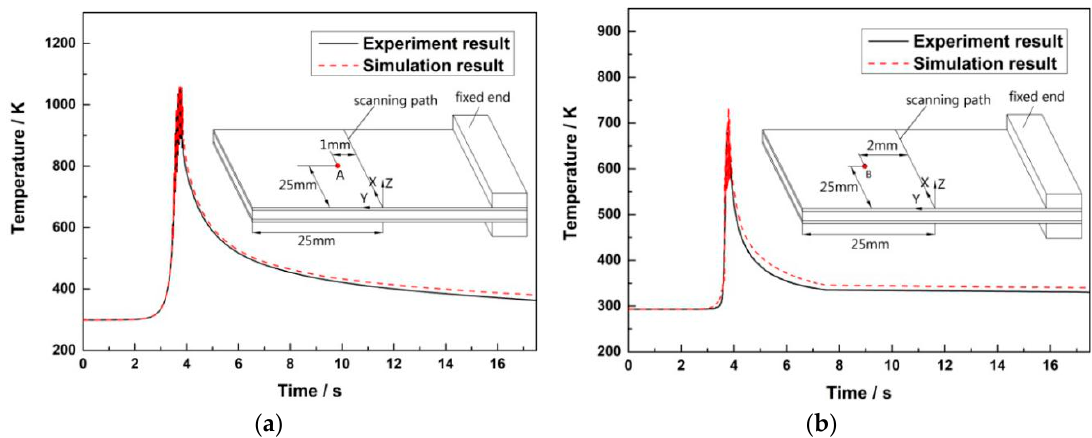
Figure 13. Temperature variations of measuring point: ( a ) Measuring point 1; ( b ) measuring point 2.